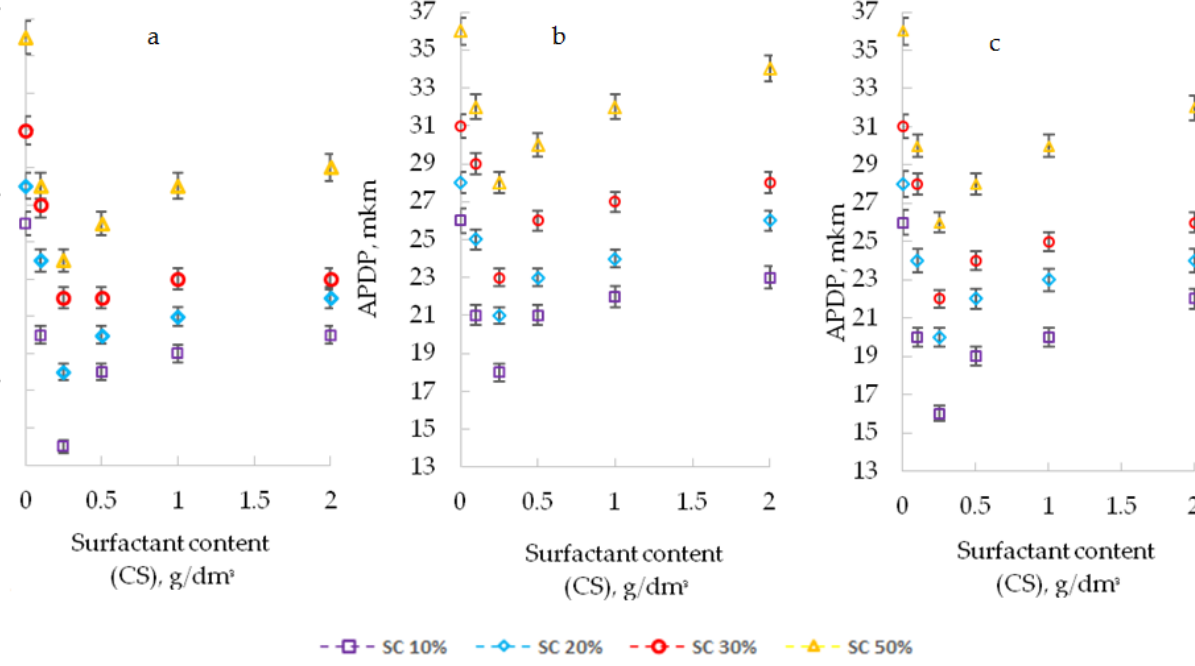
Figure 2. Influence of the type and content of surfactants (CS) on SNP at different SC (10–50%); ( а ), PEPA; ( b ), AS-1; and ( c ), Telaz.